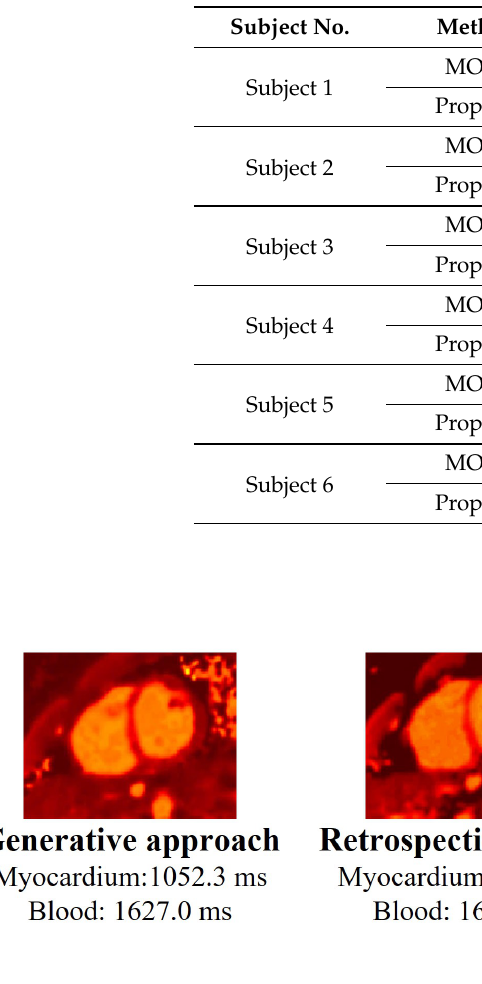
Figure 8. Comparisons of the T 1 mappings obtained from both retrospective binning and the genera- tive approach, and the 2D MOLLI [5(3)3] based on subject #1. From this, we can see that retrospective binning and the generative approach can provide comparable